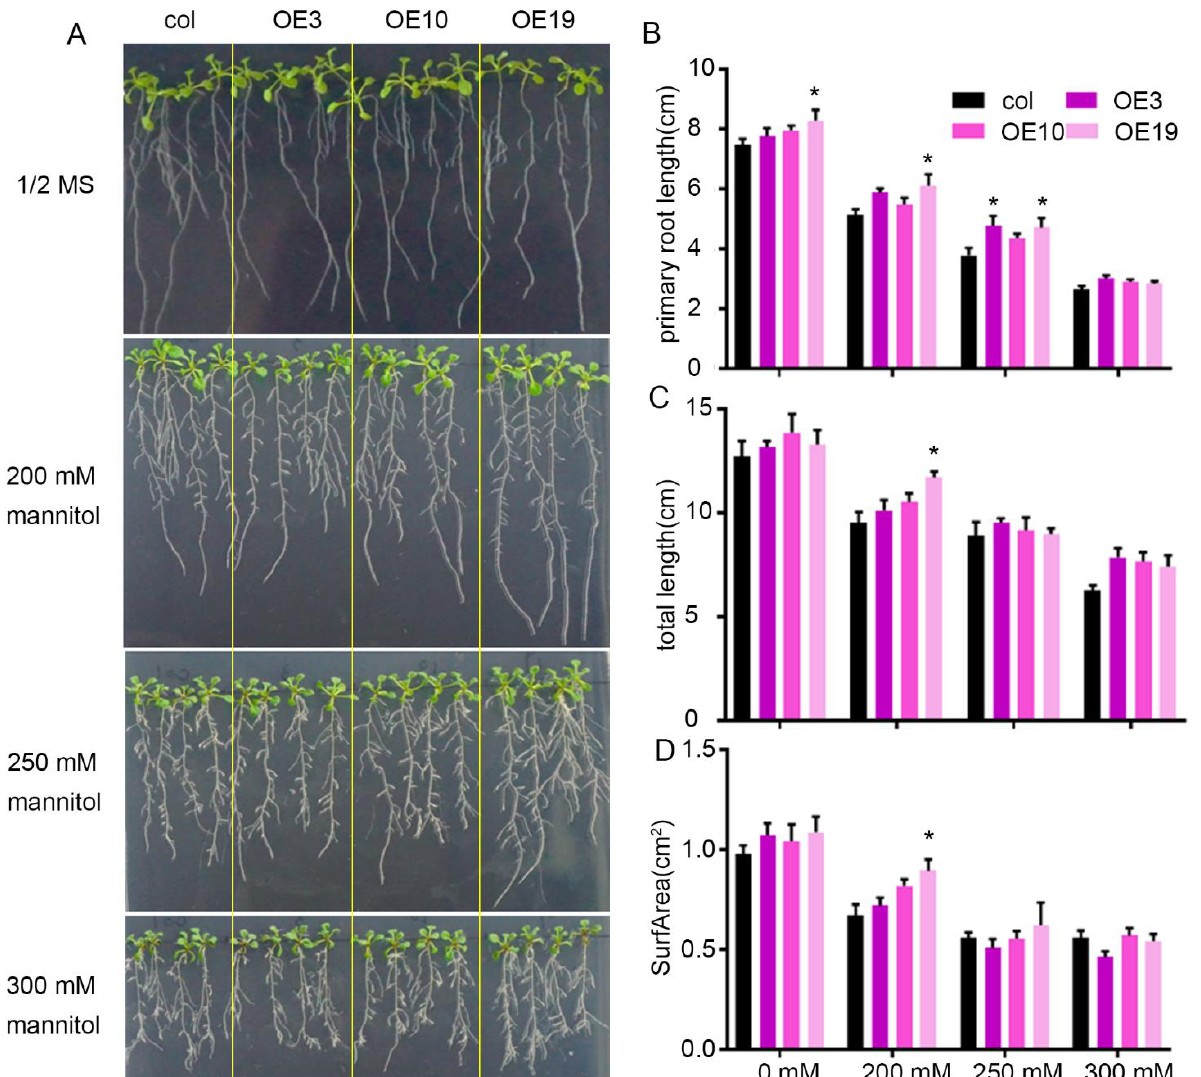
Figure 4. The phenotype of ZmLBD5 transgenic Arabidopsis with mannitol treatment: ( A ) Seedlings of wild-type and ZmLBD5 transgenic lines grown on 1/2 MS medium with 0 mM, 200 mM, 250 mM, and 300 mM mannitol. ( B – D ) Statistical analysis of primary root length, total root length, and root surface area of wild-type and ZmLBD5 transgenic seedlings grown on 1/2 MS medium with or without mannitol treatment. Mean values and standard errors (bars) are shown from 12 independent seedlings. Asterisks on bar represent the difference compared with wild type is significant (* p < 0.05). To further understand the role of ZmLBD5 under drought stress, 7-day-old plants